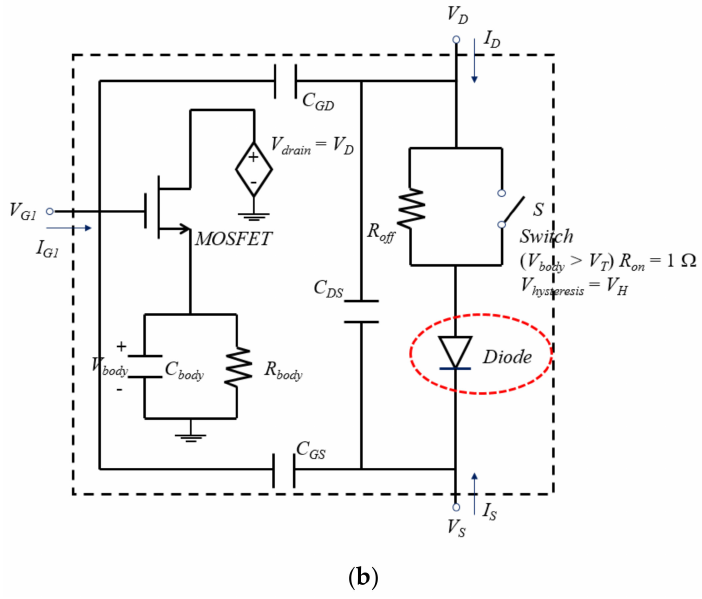
Figure 3. Circuit diagram of ( a ) the previous macro-model and ( b ) the proposed macro-model. Table 2. Summary of parameters extraction of Berkeley Short–channel IGFET Model – Independent Multi–Gate (BISM–IMG) and diode model (Level =